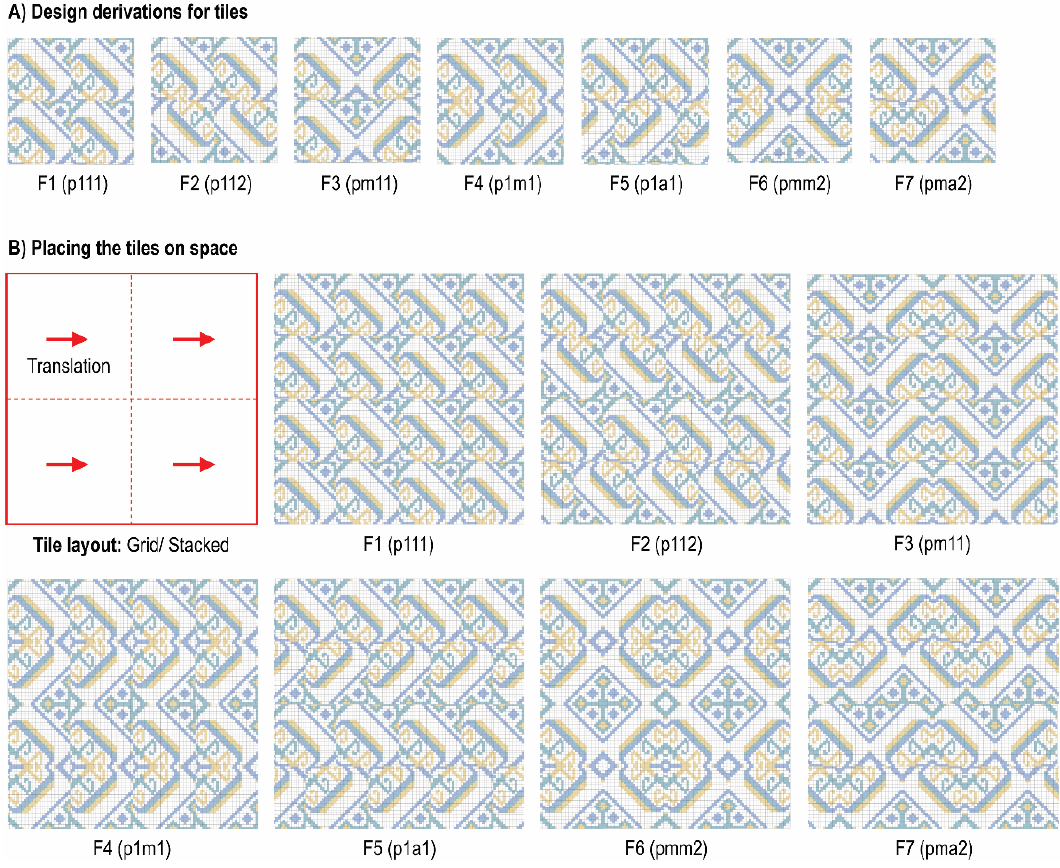
Figure 10. Design derivations from ‘design approach 2’. F1 – F7 represent sets of symbols for the seven frieze groups as indicated in Figure 3. Red arrows indicate tile placement in a horizontal orientation, similarly to translation. (Illustration by Kunkhet and Chudasri).